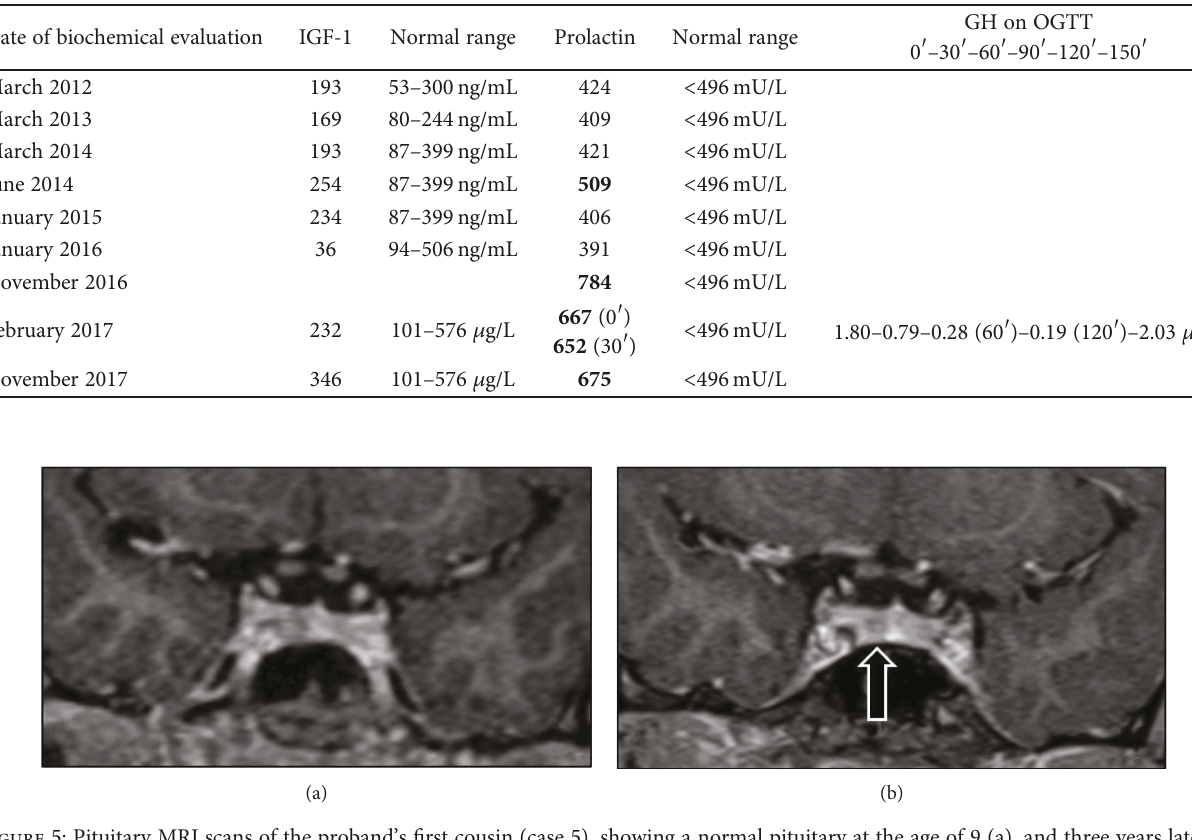
Table 3: Biochemical evaluation of the somatotrope and prolactin axes in the proband ’ s second cousin (case 5).